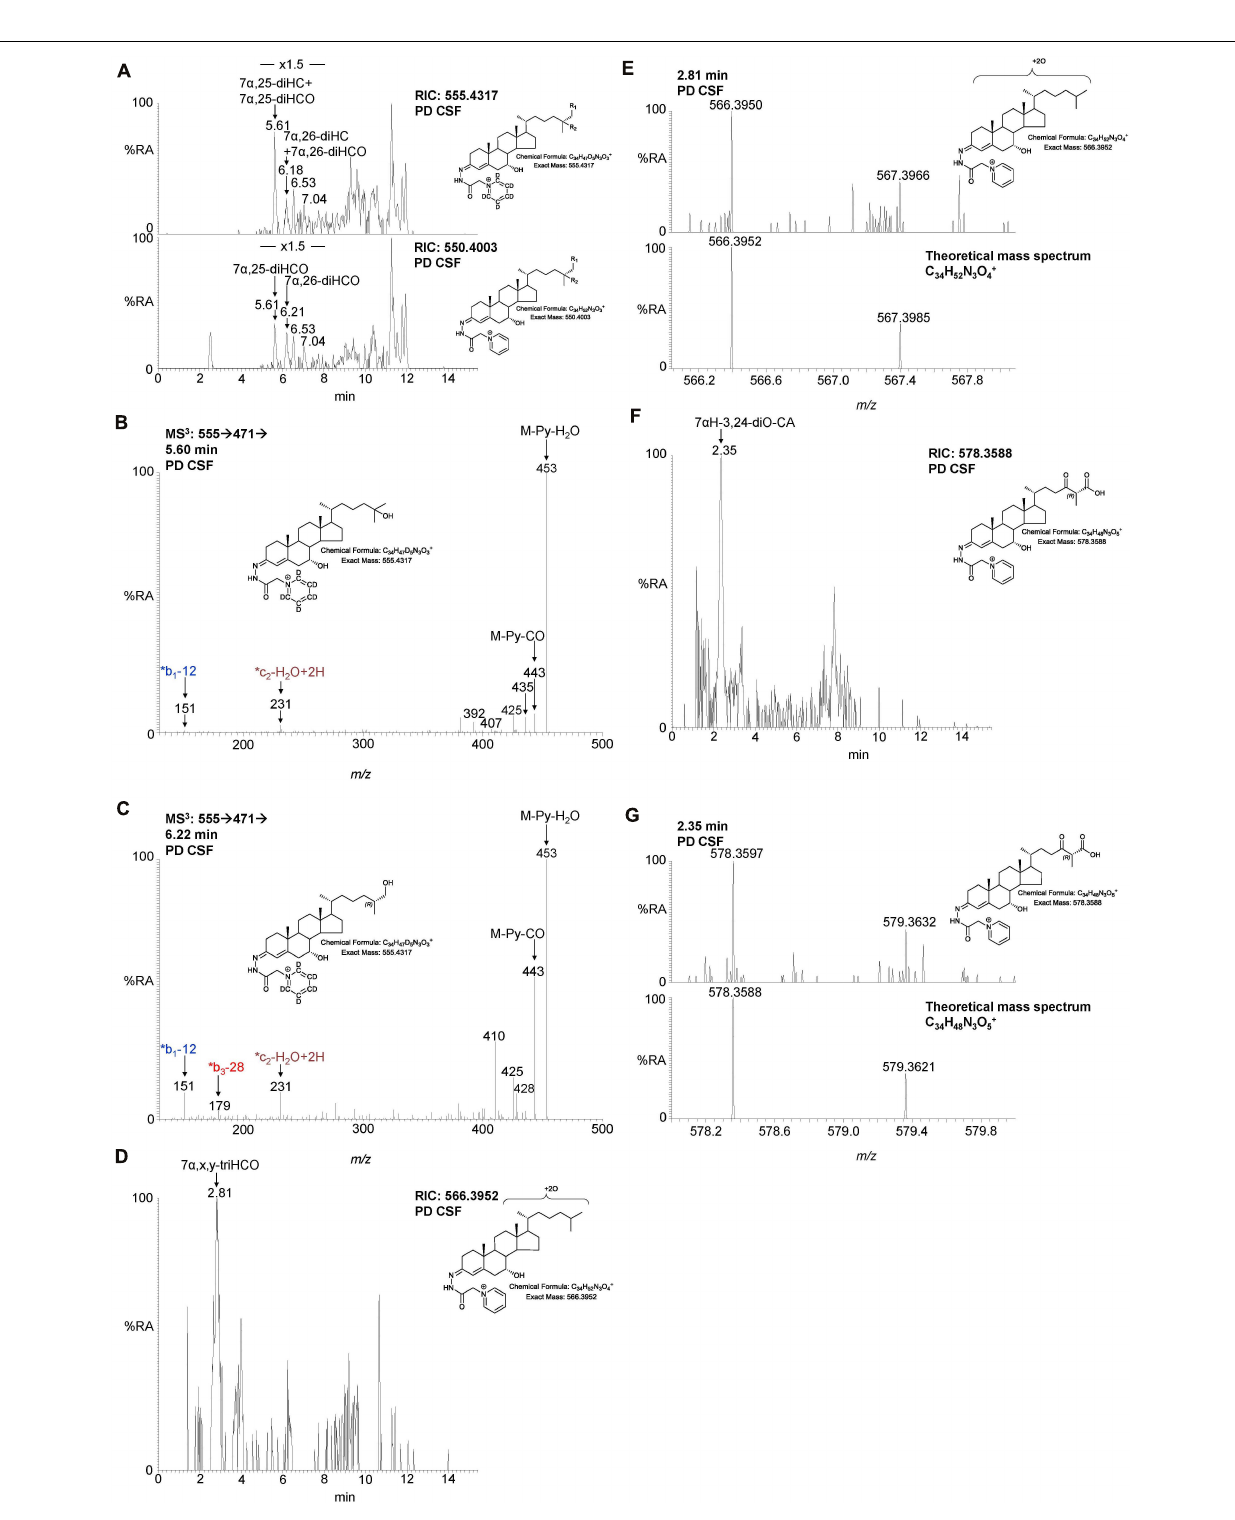
Frontiers in Aging Neuroscience |